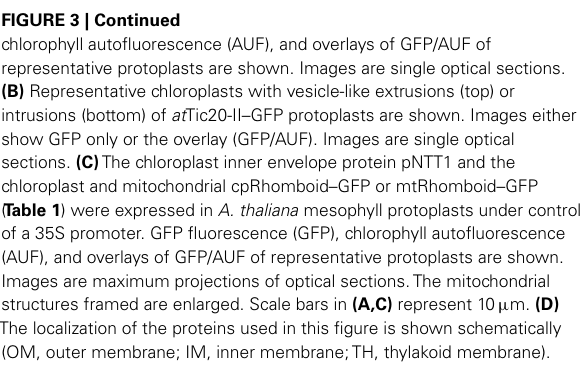
sections. (C) The chloroplast inner envelope protein pNTT1 and the chloroplast and mitochondrial cpRhomboid–GFP or mtRhomboid–GFP ( Table 1 ) were expressed in A. thaliana mesophyll protoplasts under control of a 35S promoter. GFP fluorescence (GFP), chlorophyll autofluorescence (AUF), and overlays of GFP/AUF of representative protoplasts are shown. Images are maximum projections of optical sections.The mitochondrial structures framed are enlarged. Scale bars in (A,C) represent 10 μ m. (D) The localization of the proteins used in this figure is shown schematically (OM, outer membrane; IM, inner membrane;TH, thylakoid membrane).